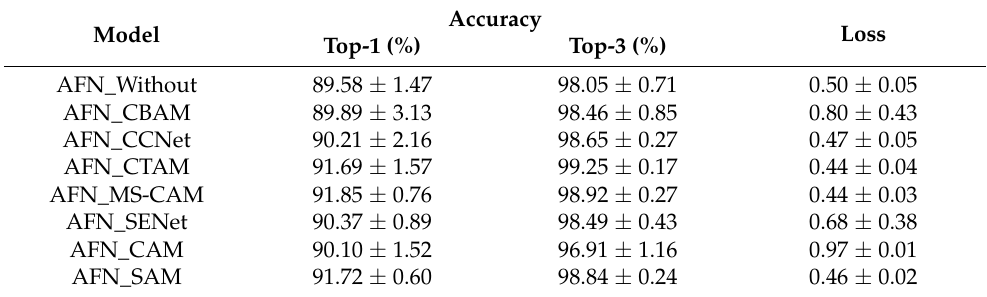
Table 4. Performance comparison of different attention